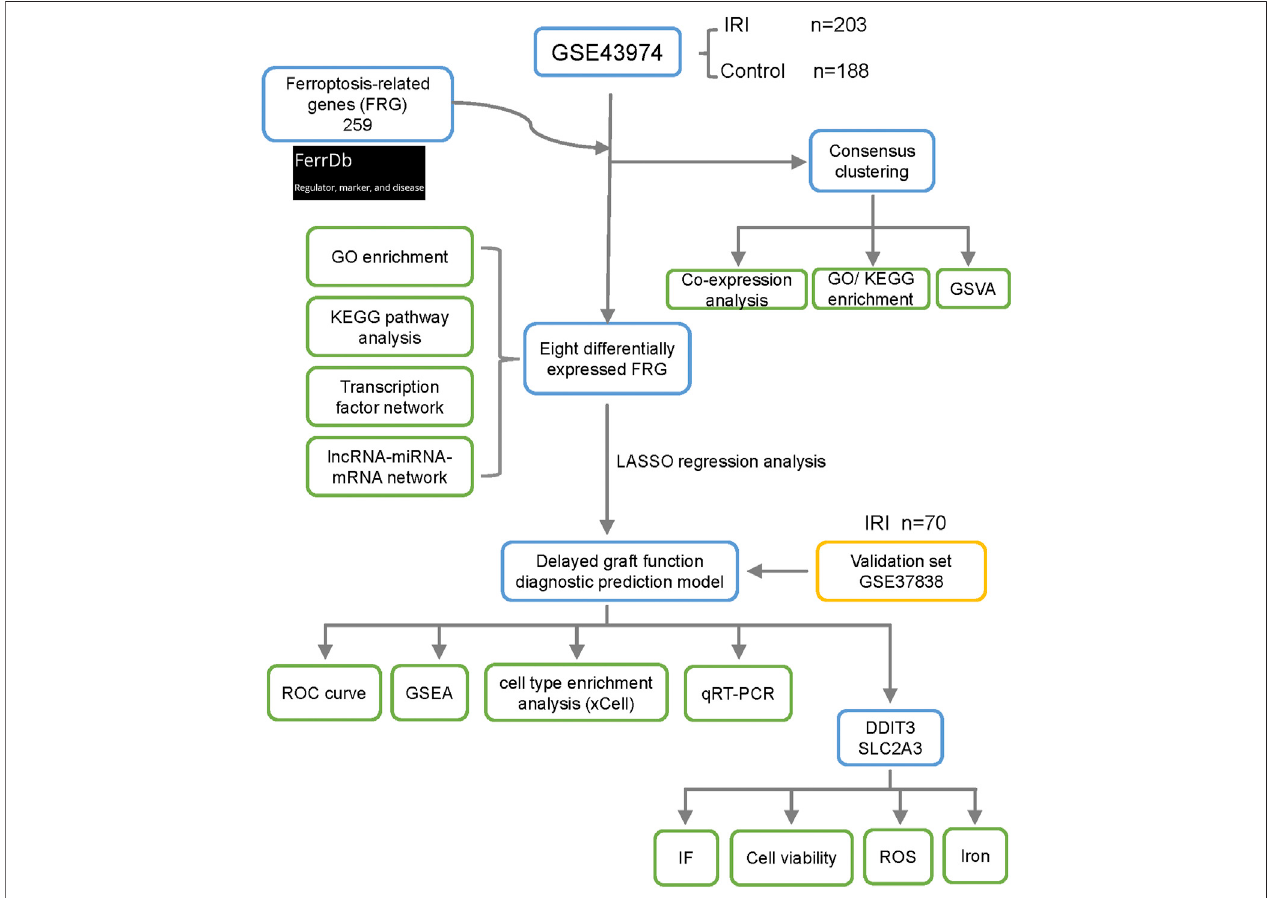
FIGURE 1 | Flowchart of research design and analyzing process of this study. A differential expression analysis was performed between the IRI group and the controlgroupintheGSE43974.FRGswereretrievedfromtheFerrDbdatabase.Aconsensusclusteringanalysiswasperformedtoidentifyferroptosis-relatedclustersin IRI samples. A total of eight differentially expressed FRGs were selected for the functional enrichment analysis and network construction. Additionally, the LASSO regression analysiswasperformedtoestablish the delayed graftfunction predictive signature.The validation set GSE37838 with 70IRIsamplesfurther veri fi ed the robustness of the signature. Cell in fi ltration of IRI samples was analyzed using the xCell algorithm. The mRNA expression of key genes was validated in the mouse IRI model by qRT-PCR. By analyzing cell viability, ROS generation, and relative iron level, knockdown of DDIT3 and SLC2A3 in HK-2 cell mitigated ferroptosis. FRG, ferroptosis-related gene; GO, gene ontology; KEGG, Kyoto Encyclopedia of Genes and Genomes; GSVA, gene set variation analysis; LASSO, least absolute shrinkage and selection operator; GSEA, gene set enrichment analysis; ROC, receiver operating characteristic; ROS, reactive oxygen species; IF, immuno fl uorescence.